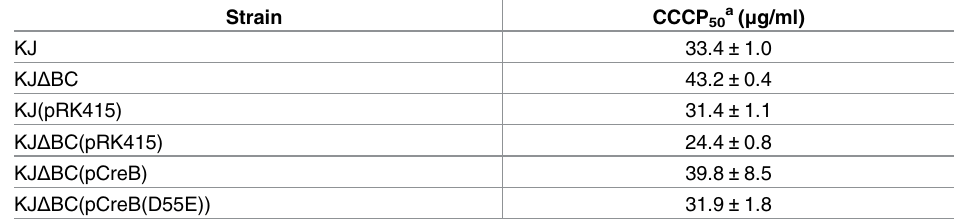
Table 2. The CCCP 50 values of S . maltophilia KJ, its isogenic creBC mutant (KJ Δ BC),and the comple-